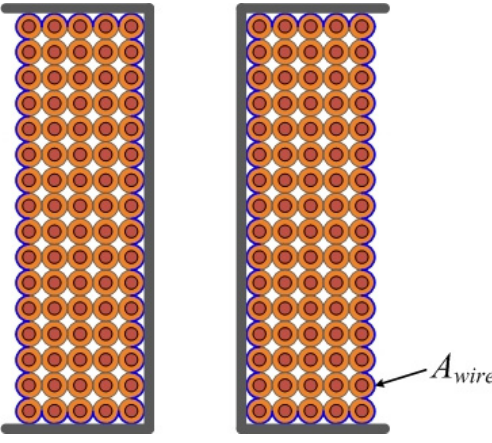
Figure 5. Heat dissipation area on coil winding.